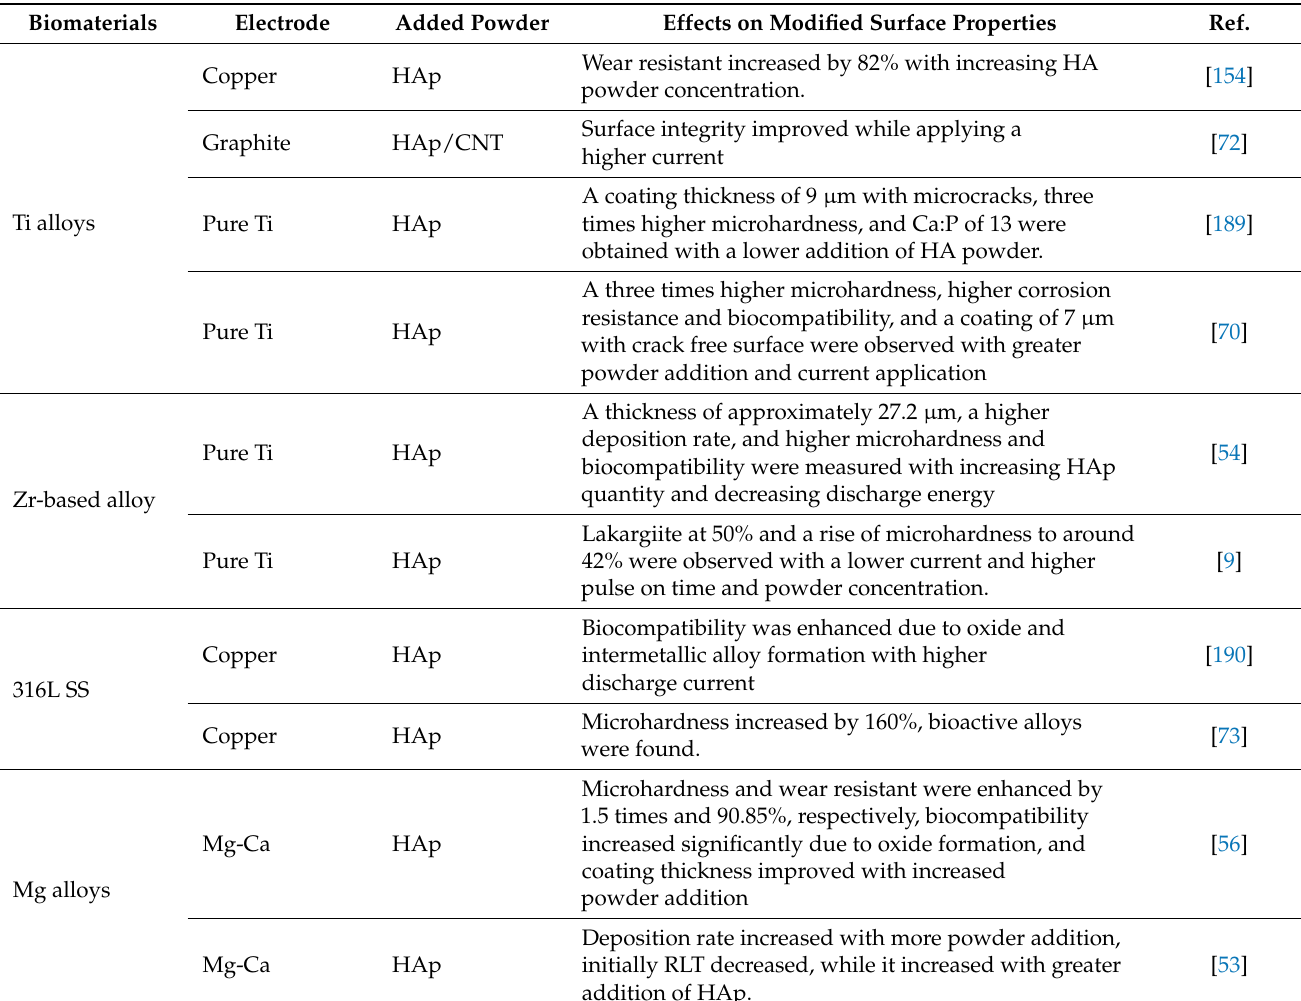
Table 5. Summary of the effects of the process factors on the treated surface